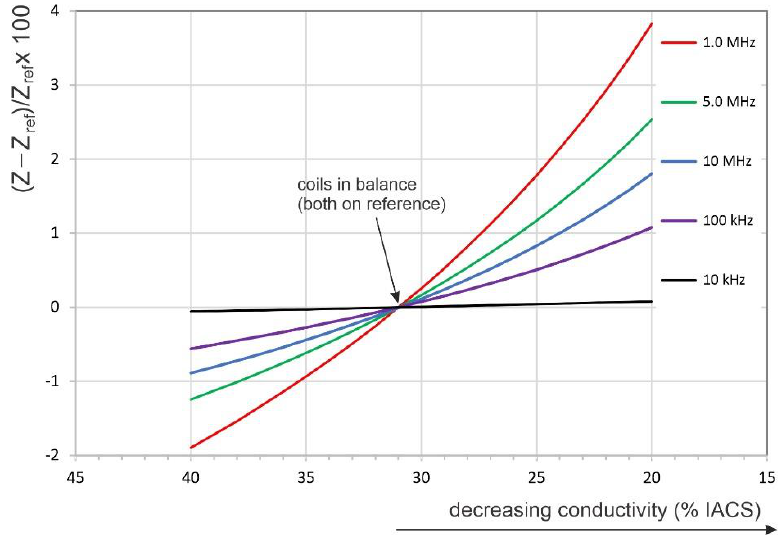
Figure 11. The relative change in coil impedance for discrete frequencies and continuous variation in conductivity.